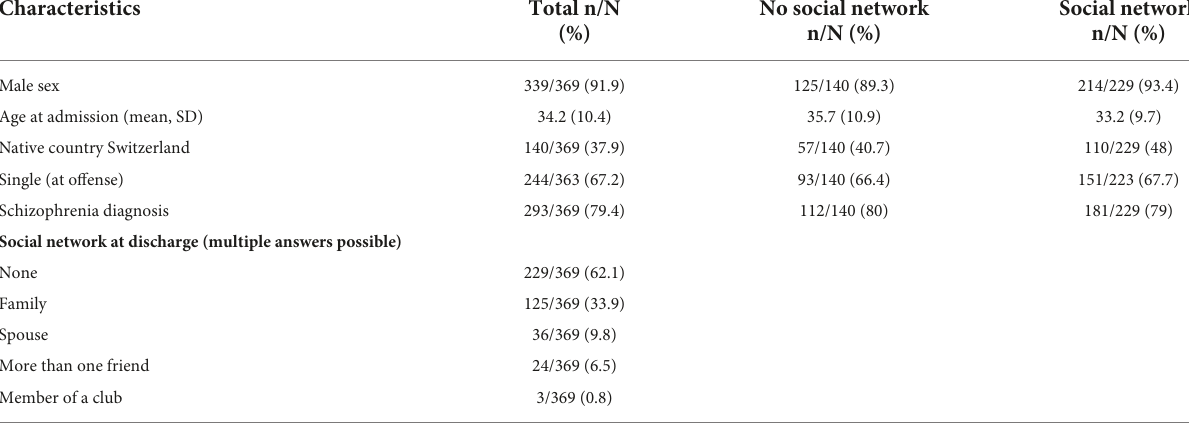
TABLE 1 Sociodemographic